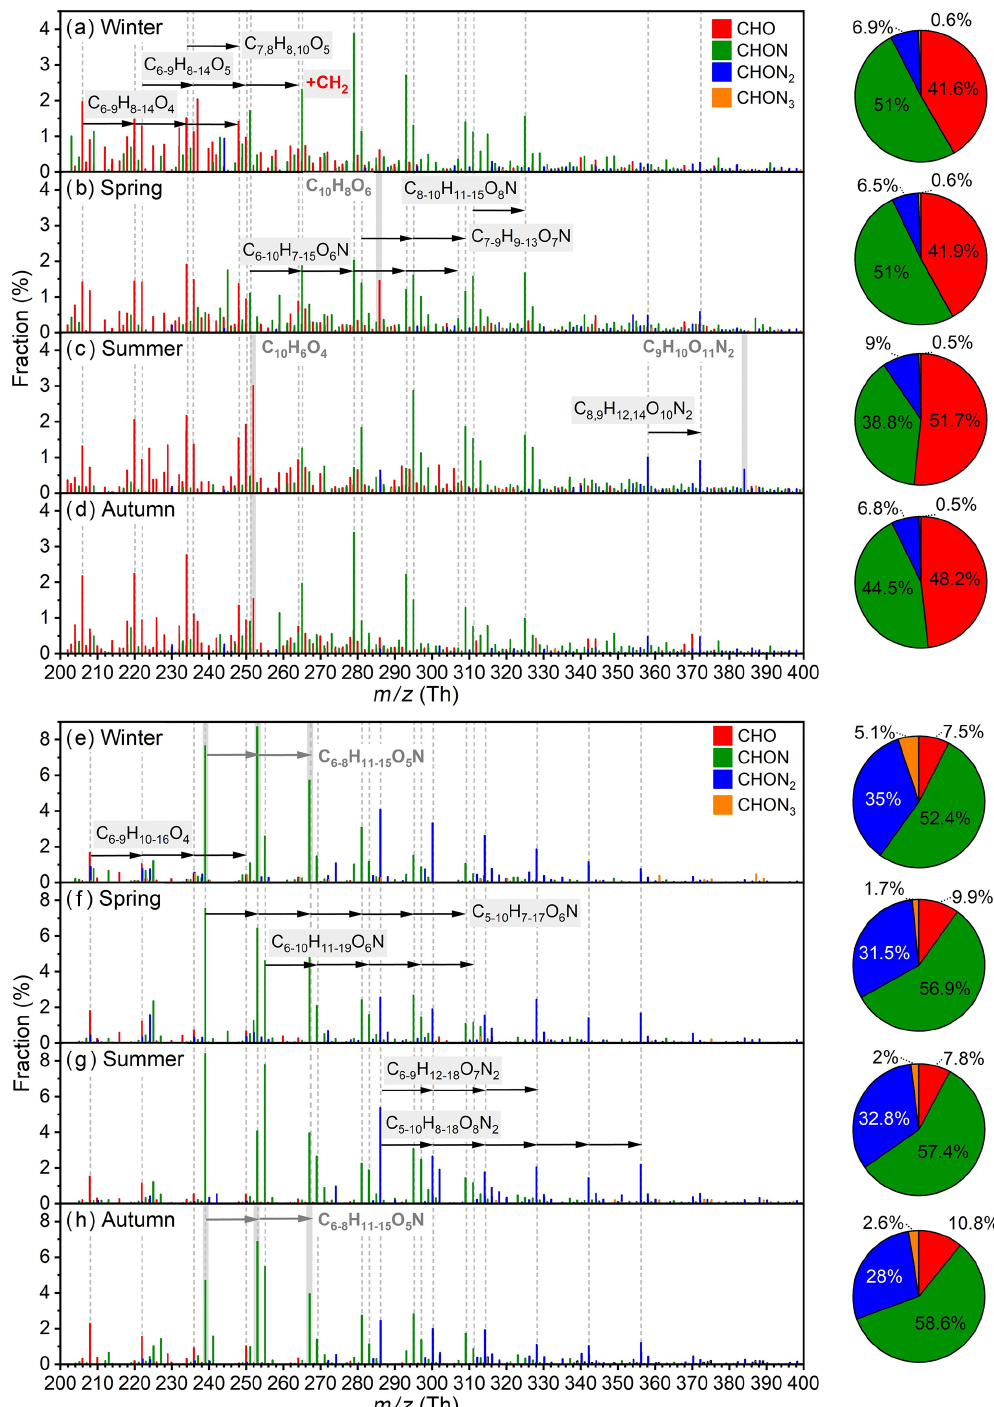
Figure 9. Fractional profiles of each aromatic OOM molecule in (a) winter, (b) spring, (c) summer, and (d) autumn and of each aliphatic OOM molecule in (e) winter, (f) spring, (g) summer, and (h) autumn. The mass-to-charge ratio ( m/z ) denotes OOM clustered with NO − or as deprotonated ones. The fraction of each compound is calculated as the ratio of its concentration to the total concentration of aromatic OOMs (a–d) or aliphatic OOMs (e–h) . The red, green, blue, and orange bars are for CHO, CHON, CHON 2 , and CHON 3 OOMs, respectively. Species marked with gray dashed lines are primary ones during the year, and species with a gray shading are special ones for specific seasons.